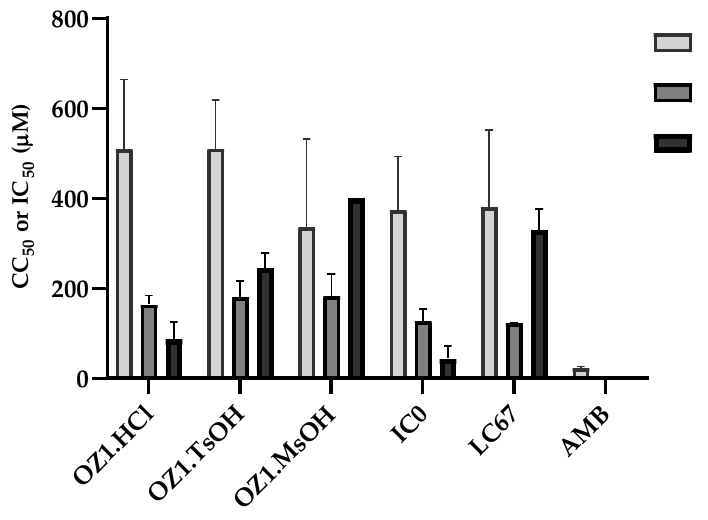
Figure 8. Graphic representation of cytotoxic (CC 50 ) and inhibitory concentrations (IC 50 ) for THP1 cell line, promastigotes, and amastigotes of L. infantum , respectively.